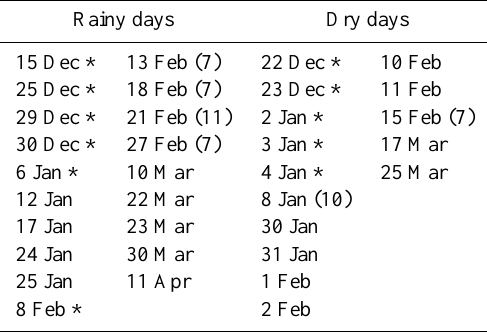
Table 2. Rainy and dry days during December 1997 to April 1998. Days for which little or no BLR data was available are indicated with asterisks, and for the days in which morning BLR data were lacking we indicate the earliest hour of the day at which data was available.